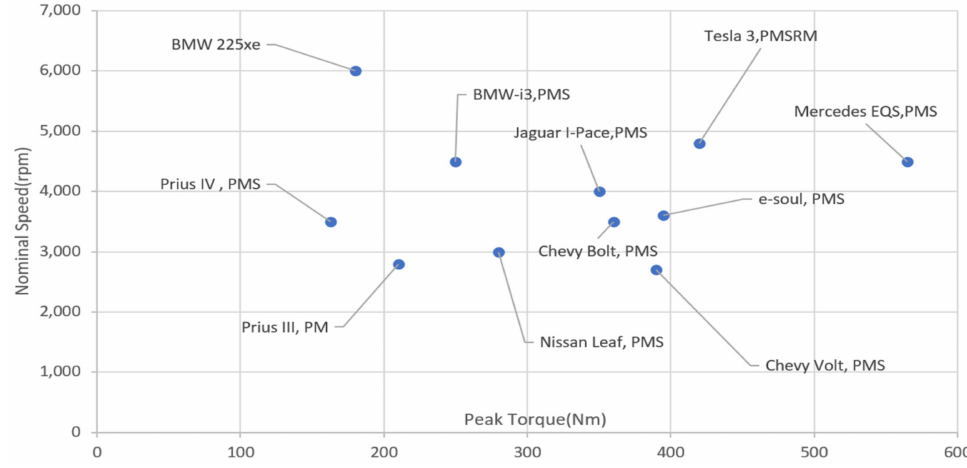
Figure 14. Nominal speed over peak torque overview for the investigated motors